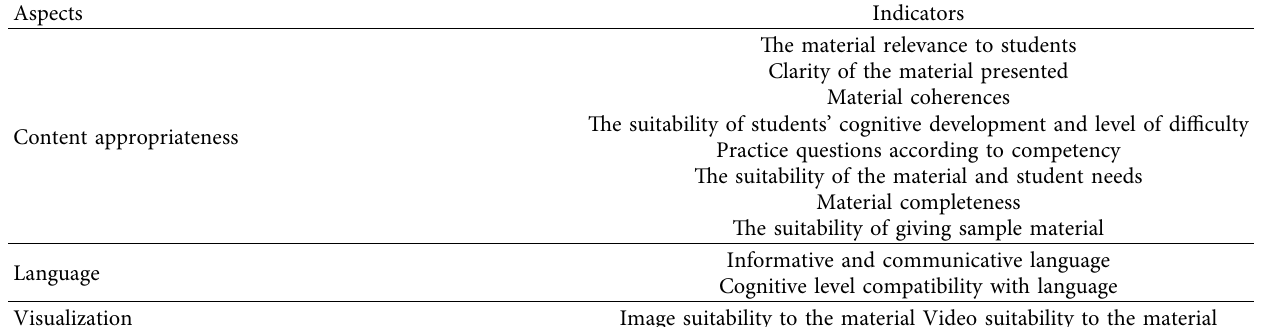
Table 3: Material validation.